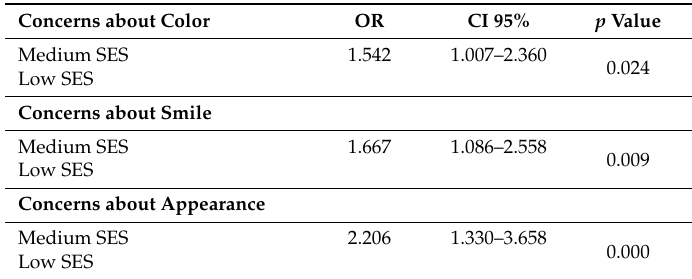
Table 2. Bivariate analysis between self-perception and different socioeconomic levels in the TF 4–5 population.